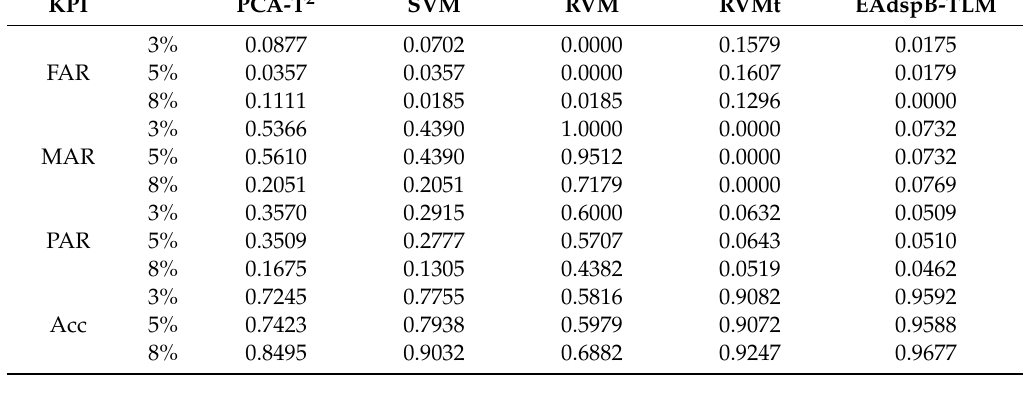
Table 5. Monitoring results for filamentous sludge bulking.